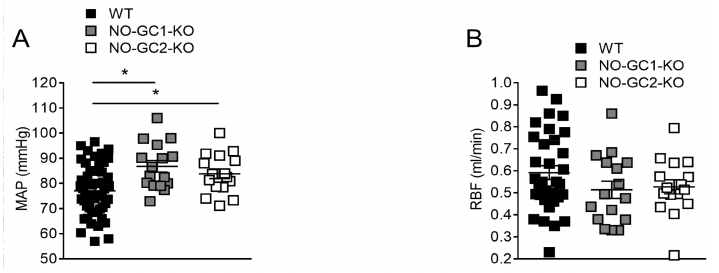
Figure 1. Increased blood pressure but normal renal blood flow in anesthetized NO-sensitive guanylyl cyclase1 knockout (NO-GC1-KO) and NO-GC2-KO mice. ( A ) Blood pressure was significantly increased in NO-GC1-KO ( n = 16) and NO-GC2-KO ( n = 17) compared to WT ( n = 54) mice; ( B ) Renal blood flow was not different in unconscious WT ( n = 33), NO-GC1-KO ( n = 16) and NO-GC2-KO ( n = 16) mice. Data represent means ± standard error of the mean (SEM); * p < 0.05 vs. wildtype (WT). One-way standard error of the mean (ANOVA) followed by Bonferroni’s multiple comparison post hoc